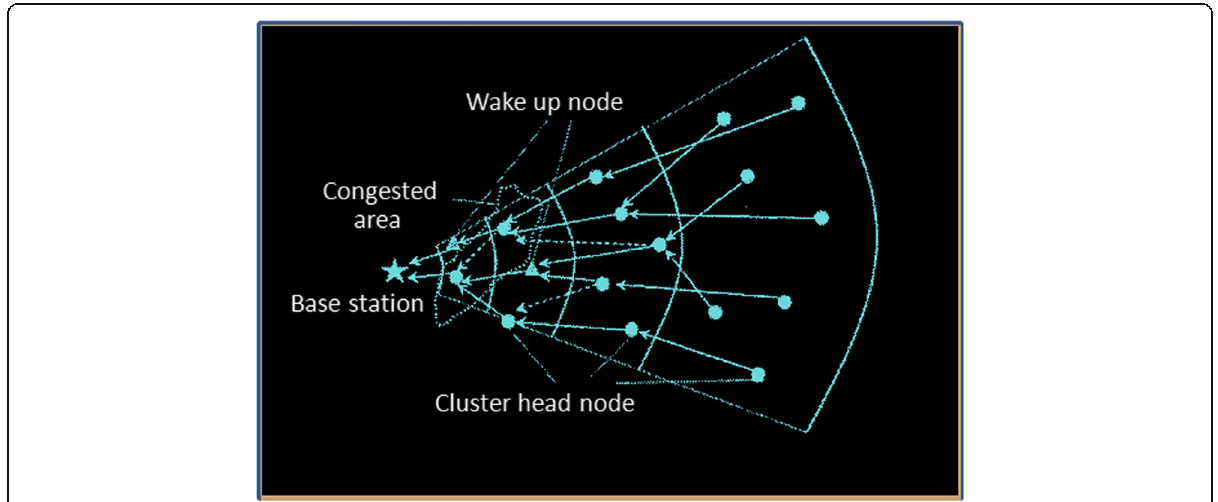
Fig. 5 Schematic diagram of multi-hop of four-layer and four-hop